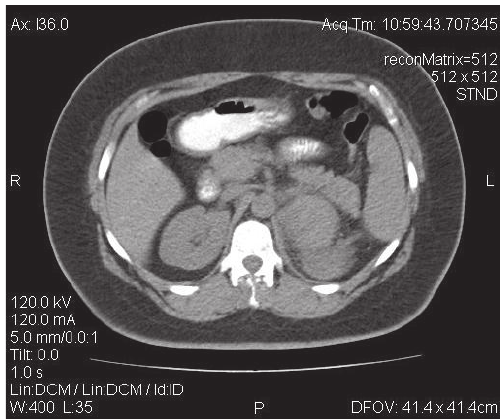
Figure 2: A CT scan image showing the adrenal tumor and the pertinent hematoma.